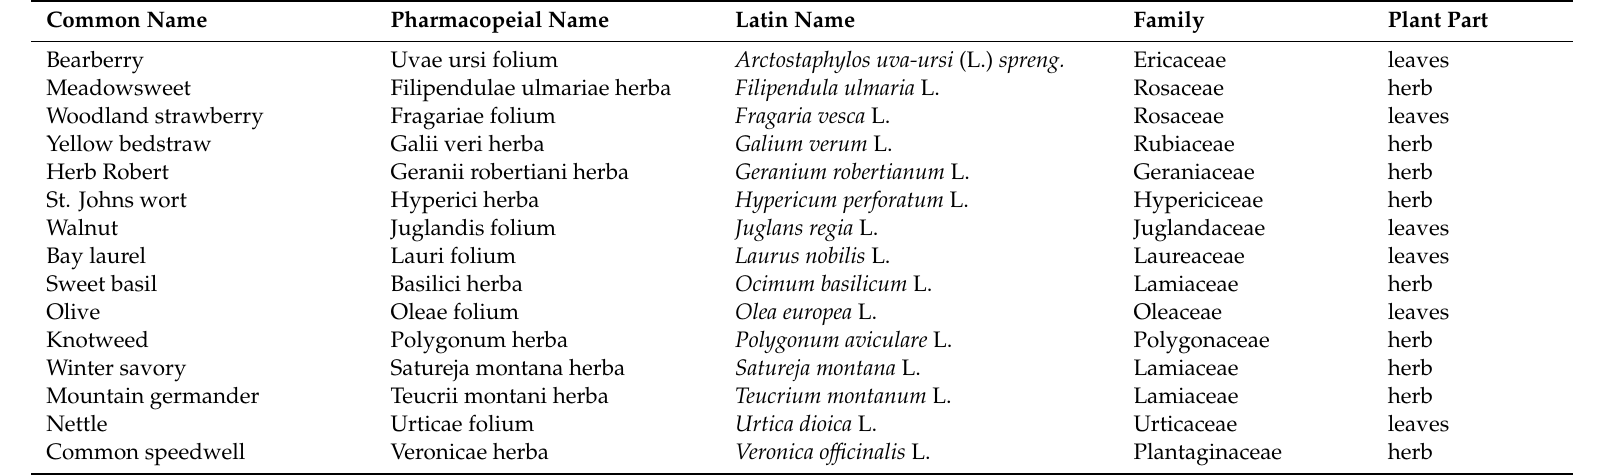
Table 1. List of investigated